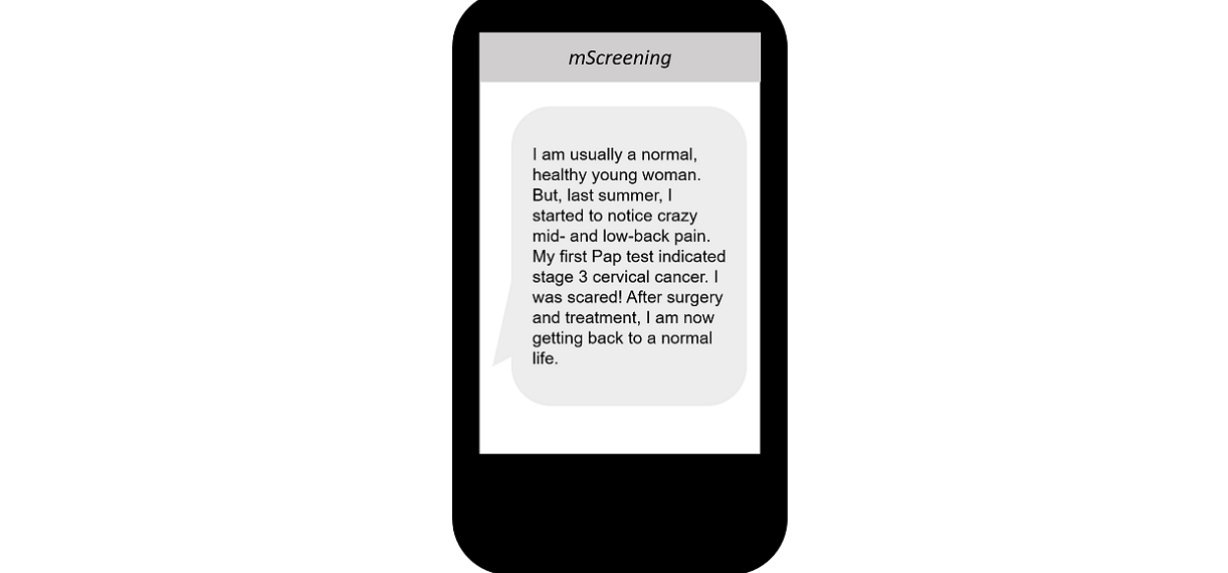
Figure 2. Mobile screening message example: used a testimony from a young Korean American immigrant woman.